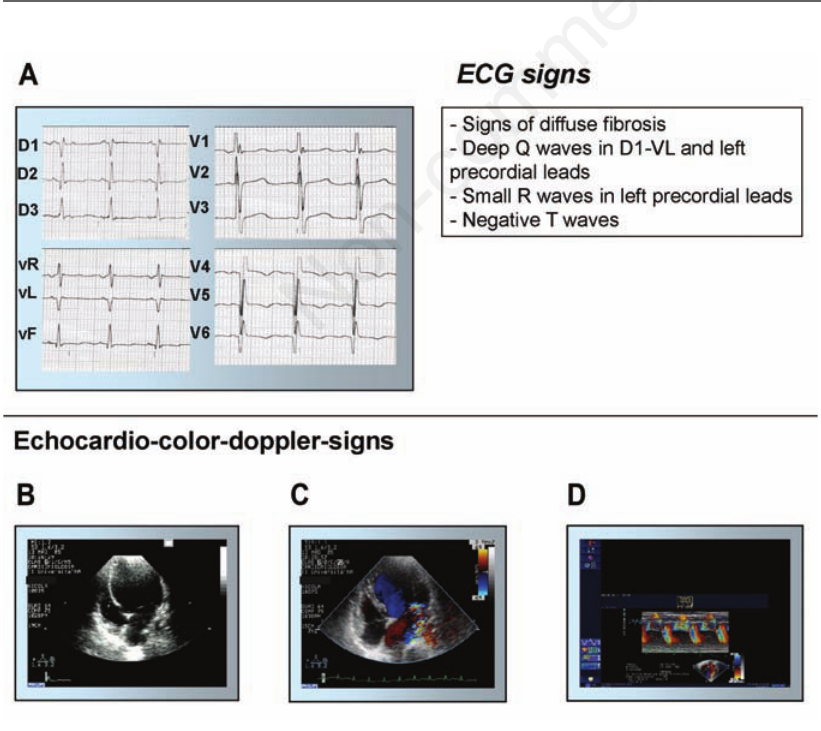
Figure 7. Dilated stage of dystrophinopathic cardiomyopathy: elettrocardiographic (ECG) and echocardiographic signs. A) ECG signs; B) Dilation of heart chambers: ejec- tion fraction <45%, thin ventricular walls; C) and D) Mitral and tricuspid